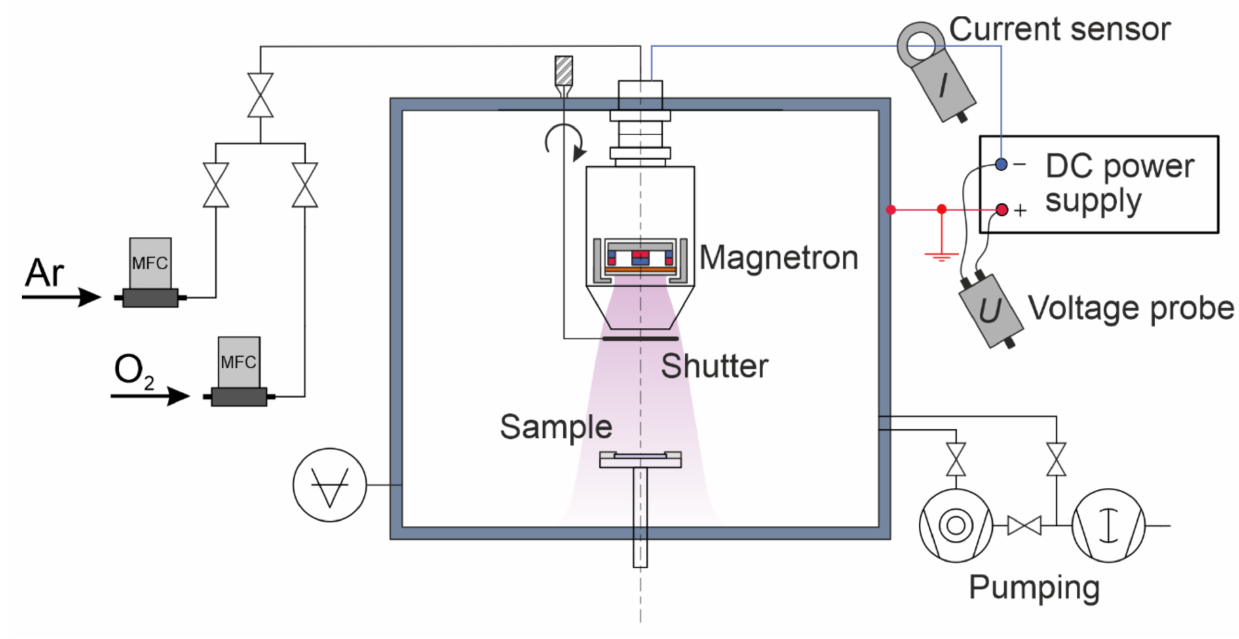
Figure 1. Schematic of a magnetron deposition